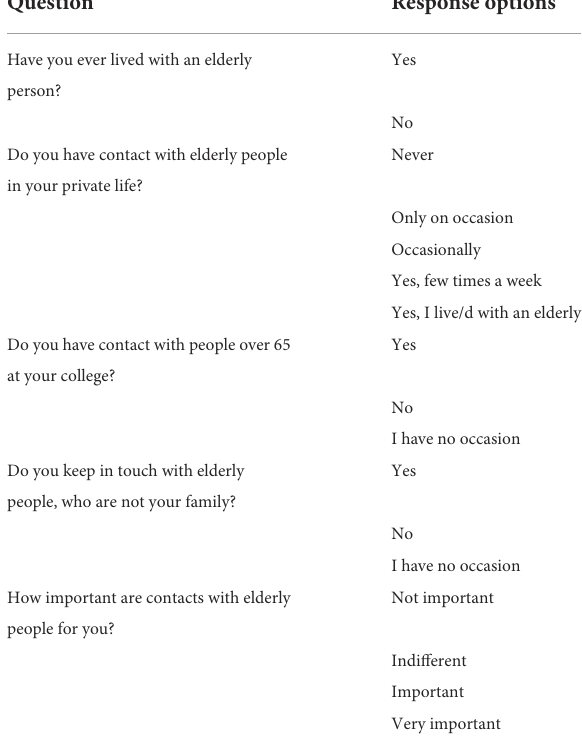
TABLE 1 Characteristics of the “contact with older people”